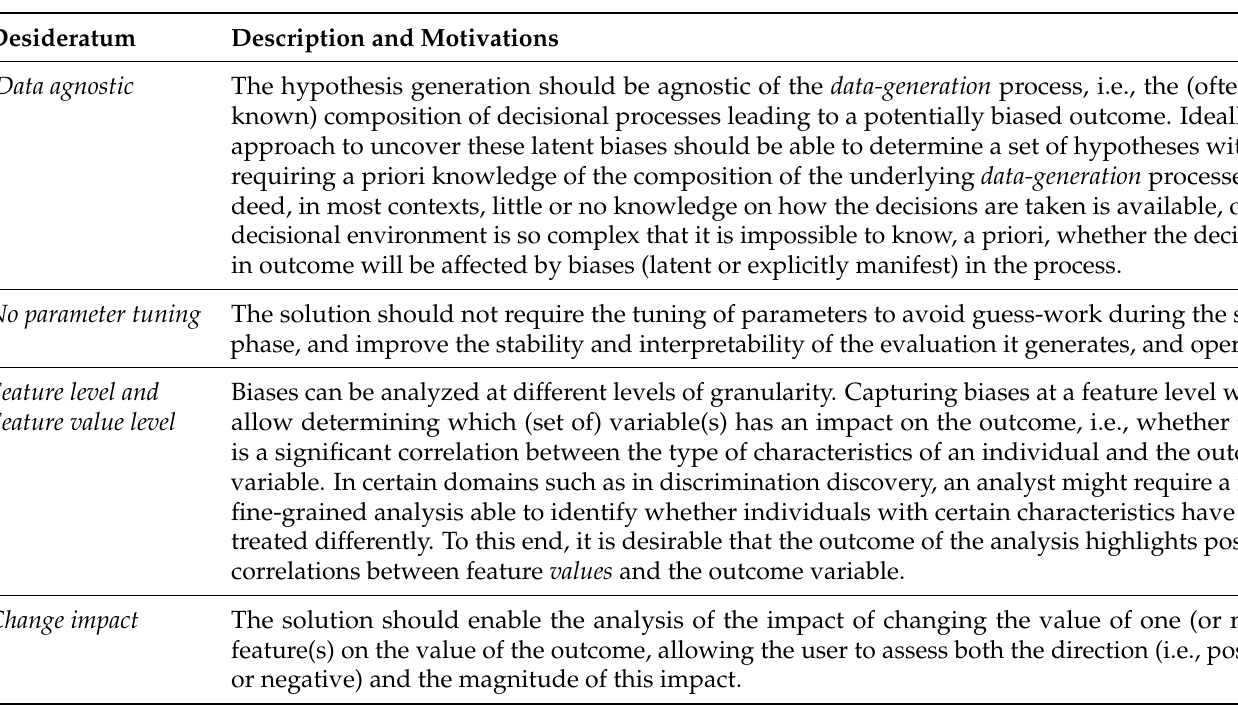
Table 2. Desiderata for bias detection and